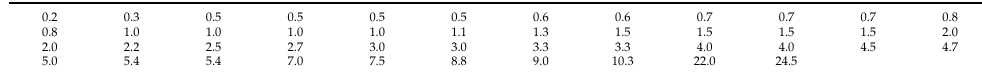
Table 5. Repair times for the airborne communication transceiver dataset.